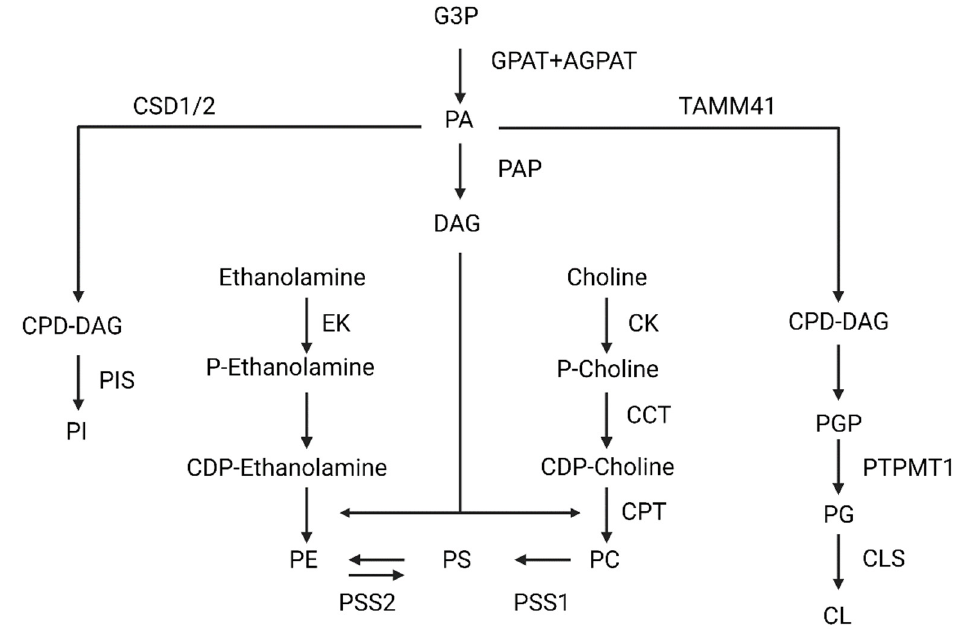
Figure 1. Scheme of phosphatidylcholine (PC), phosphatidylserine (PS), phosphatidylethanolamine (PE), cardiolipin (CL), and phosphatidylinositol (PI). Abbreviations: glycerol-3-Phosphate (G3P); glycerol-3-phosphate acyltransferase (GPAT); 1-acylglycerol-3-phosphate-O-acyltransferase (AGPAT); phosphatidic acid (PA); phosphatidic acid phosphatase (PAP); diacylglycerol (DAG); ethanolamine kinase (EK); phosphatidylserine synthase 2 (PSS2); phosphatidylserine synthase 1 (PSS1); CDP-choline:1,2-diacylglycerol cholinephosphotransferase (CTP); choline-phosphate cytidylyltransferase (CCT); choline kinase (CK); Cytidine diphosphate diacylglycerol synthetases 1/2 (CSD1/2); cytidine diphosphate diacylglycerol (CDP-DAG); (PIS); Mitochondrial translocator assembly and maintenance protein 41 (TAMM41); phosphatidylglycerophosphate (PGP); Protein Tyrosine Phosphatase Mitochondrial 1 (PTPMT1); phosphatidylglycerol (PG); cardiolipin synthase (CLS). Finally, CDP-choline: 1,2-diacylglycerol cholinephosphotransferase, (CTP)